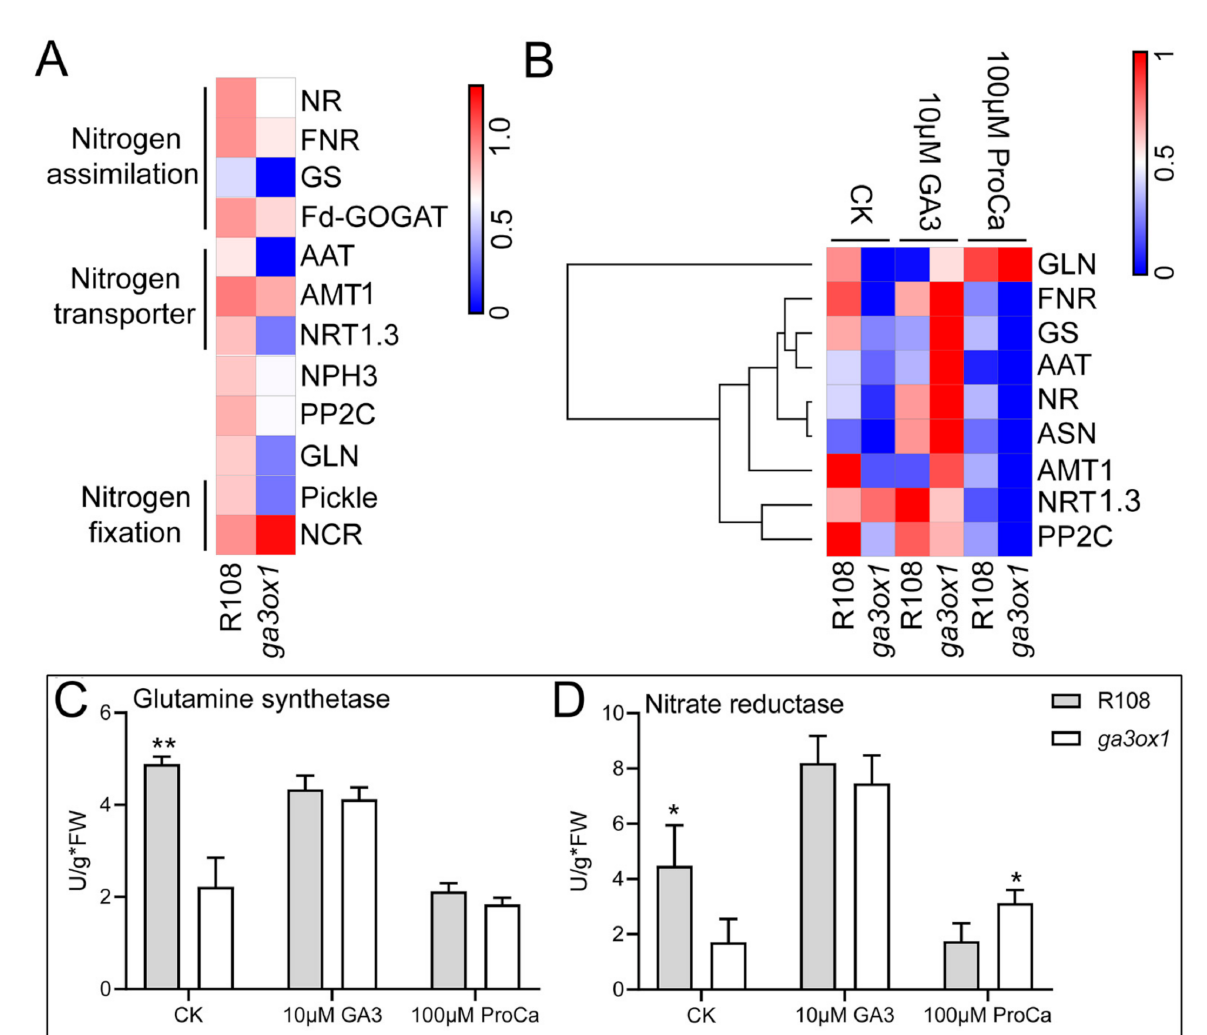
Figure 8. GAs induced the expression of genes related to nitrogen metabolism and positively regulated genes involved in nitrogen transport. ( A ) The heat map of DEPs involved in nitrogen metabolism and transport. ( B ) The heat map of transcriptional expression levels of differentially expressed genes related to nitrogen metabolism and transport under control, GA 3 treatment and prohexadione calcium treatment. ( C , D ) Determination of glutamine synthase activity and nitrate reductase activity in 1-month-old wild-type R108 and ga3ox1 mutant leaves under control, GA treatment and prohexadione calcium treatment. The heatmap was built using the OmicShare tools, a free online platform for data analysis (http://www.omicshare.com/tools, 19 May 2020). According to the color scale on the right of the Figure, each colorized cell represents the averaged spot quantity, and the color scale indicates fold change of the mRNA expression levels. * p < 0.05, and ** p < 0.01 by Duncan